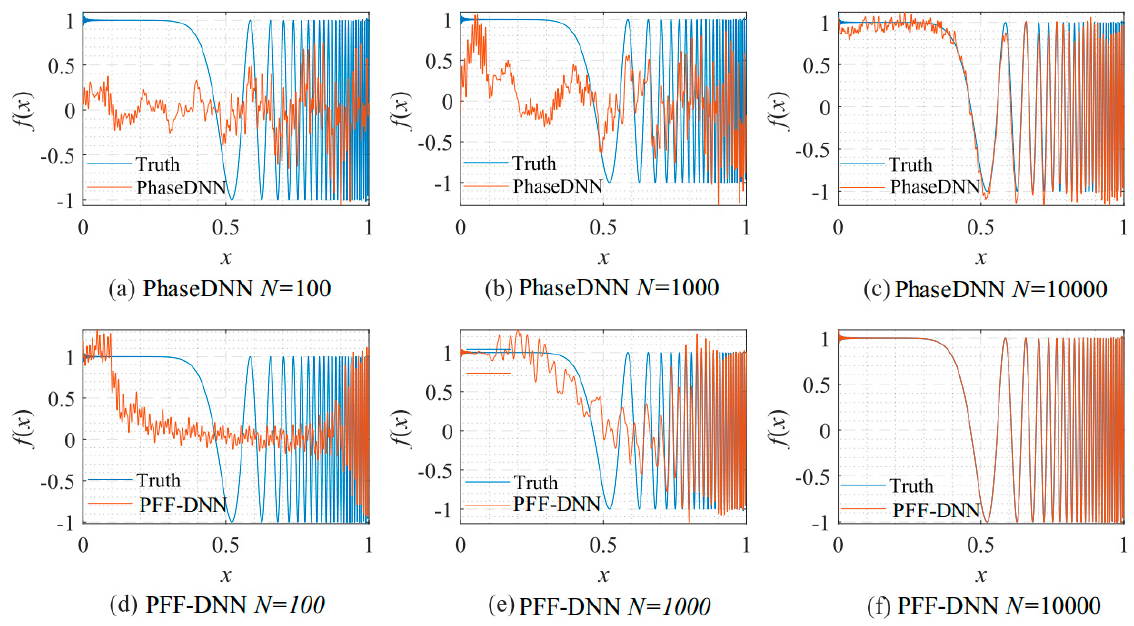
Figure 17. The influence of N on the algorithm performance. Fitting results of the PhaseDNN method when Δ ω = 11: ( a ) N = 100; ( b ) N = 1000; and ( c ) N = 10,000. Fitting results of the PFF-DNN method when Δ ω = 11: ( d ) N = 100; ( e ) N = 1000; and ( f ) N = 10,000.